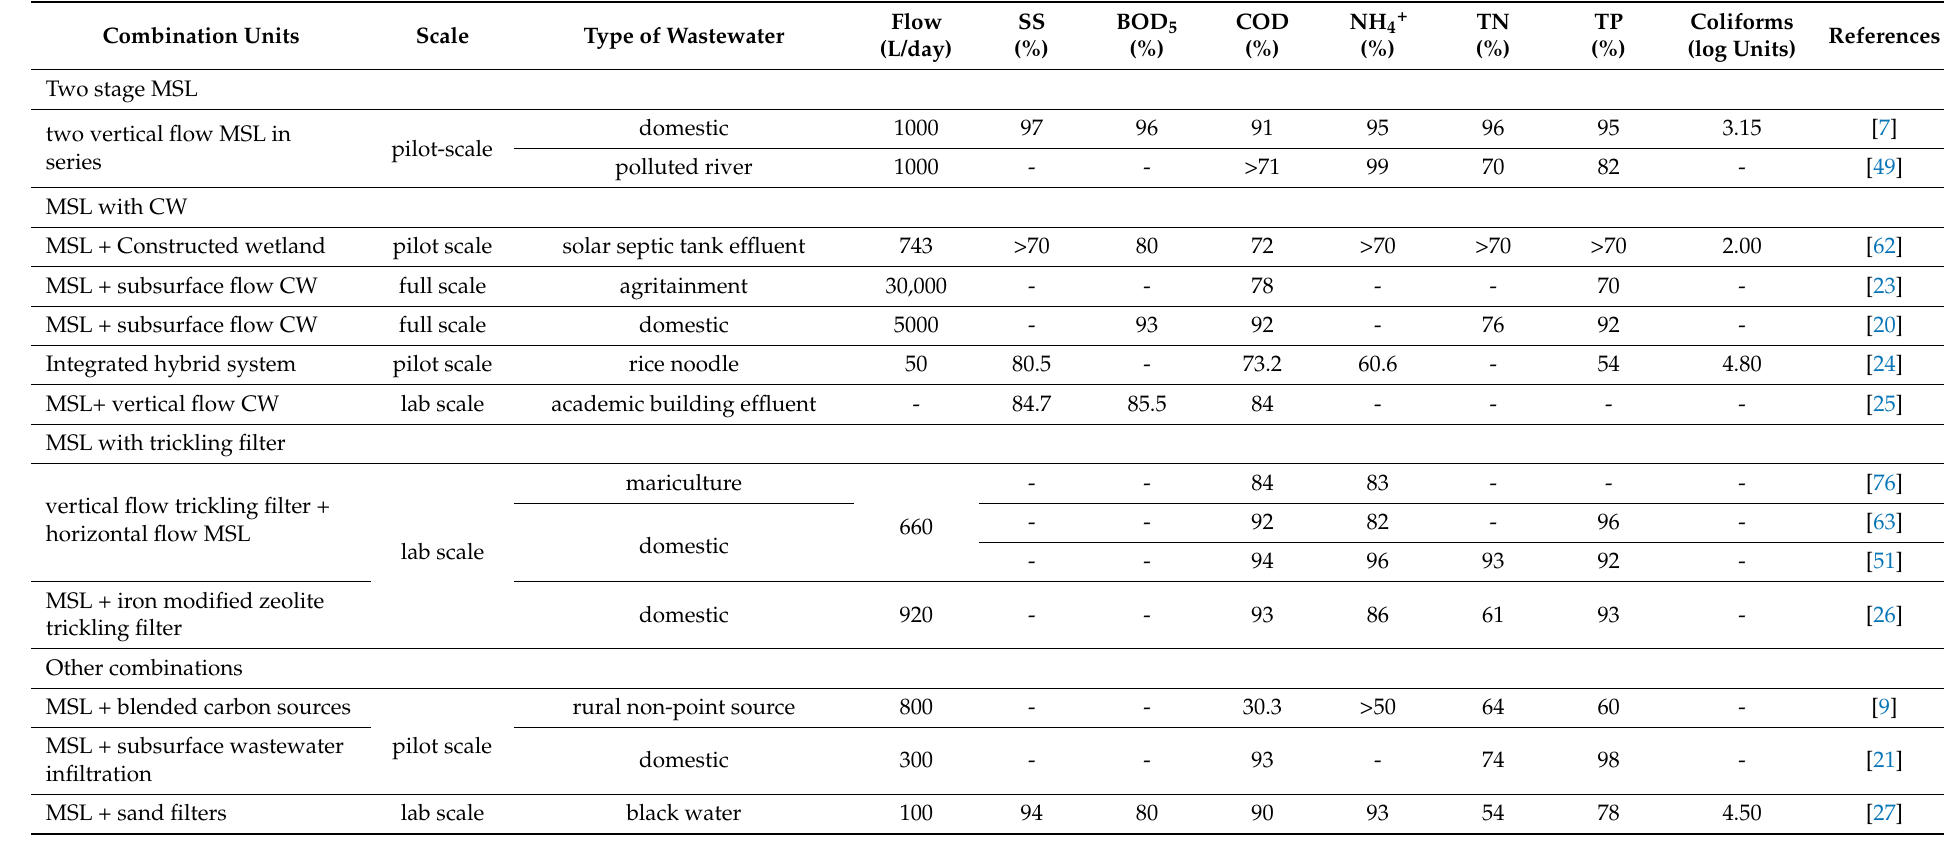
Table 1. Various combinations of the MSL technology with other systems according to the literature